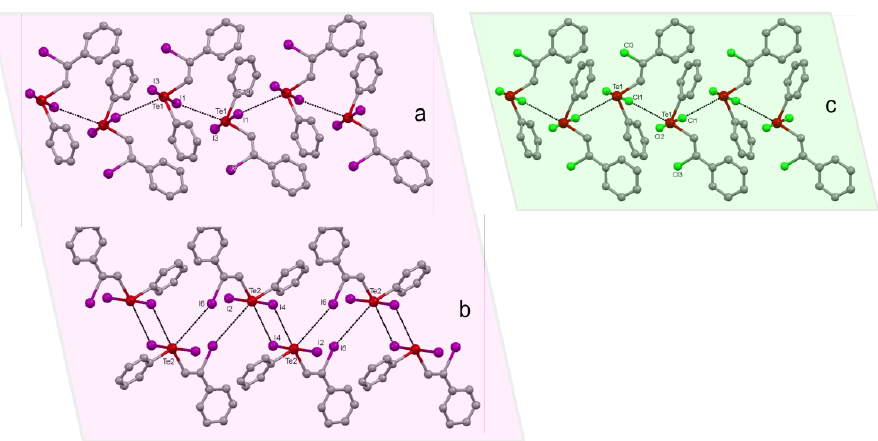
Figure 6. Fragment of packing of (Z)-2-iodo-2-phenylvinyl)-phenyl-tellurium diiodide (Z’ = 2, a , b ) and (Z)-2-chloro-2-phenylvinyl)-phenyl-tellurium dichloride (Z’ = 1, c ), showing the parallel chains of Te---I ChB stabilized catemer ( a ) and centrosymmetric dimers ( b ) in Ph(I)C=C(H)TeI 2 Ph (CUCQEX) and Te---Cl ChB stabilized catemer chains in in Ph(Cl)C=C(H)TeCl 2 Ph (GOKFAO). Hydrogen atoms are omitted for clarity.